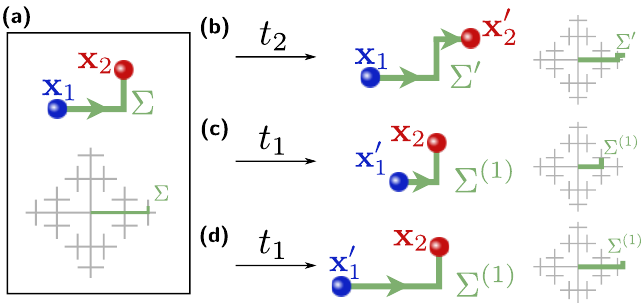
eff Figure 2: The hopping part of the effective Hamiltonian ˆ describes NN tunneling t H of holes 1 ( t ) and 2 ( t ) on the square lattice. The string Σ from hole 1 to 2 changes 1 2 accordingly. We illustrate a typical initial state (a), which is coupled to neighboring string states on the Bethe lattice by t (b). The coupling t creates a string state 2 1 Σ ( 1 ) which is a further neighbor of Σ on the Bethe lattice, either by re-tracing (b) or extending (d) the first string